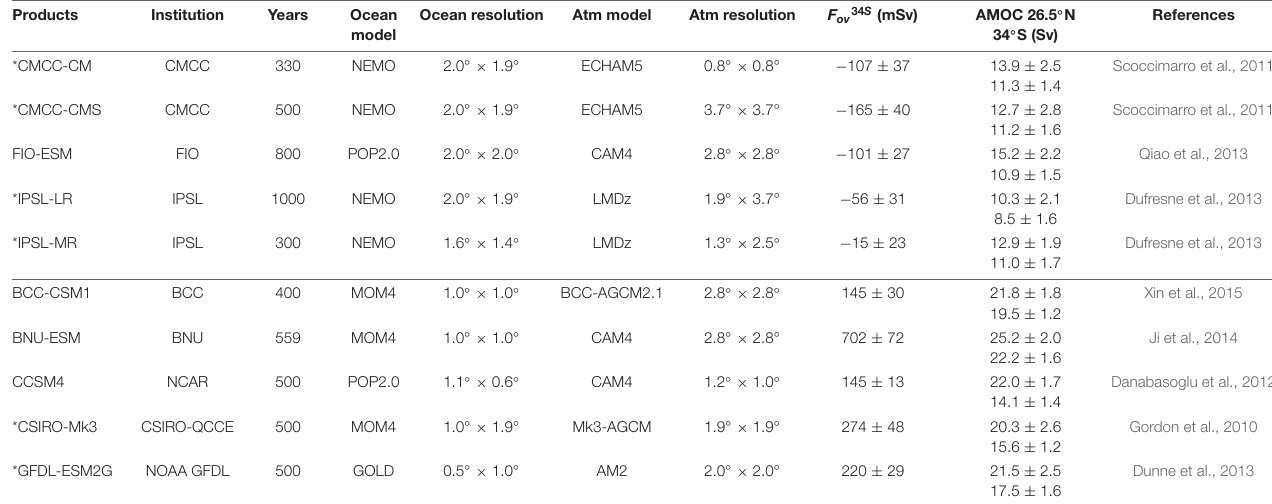
TABLE 1 | List of selected CMIP5 products with the institution that conducted the simulations, the length of each simulation, the models and their horizontal resolutions, the F ov at 34 ◦ S and the AMOC strengths at 26.5 ◦ N and 34 ◦ S, ± their interannual variabilities.